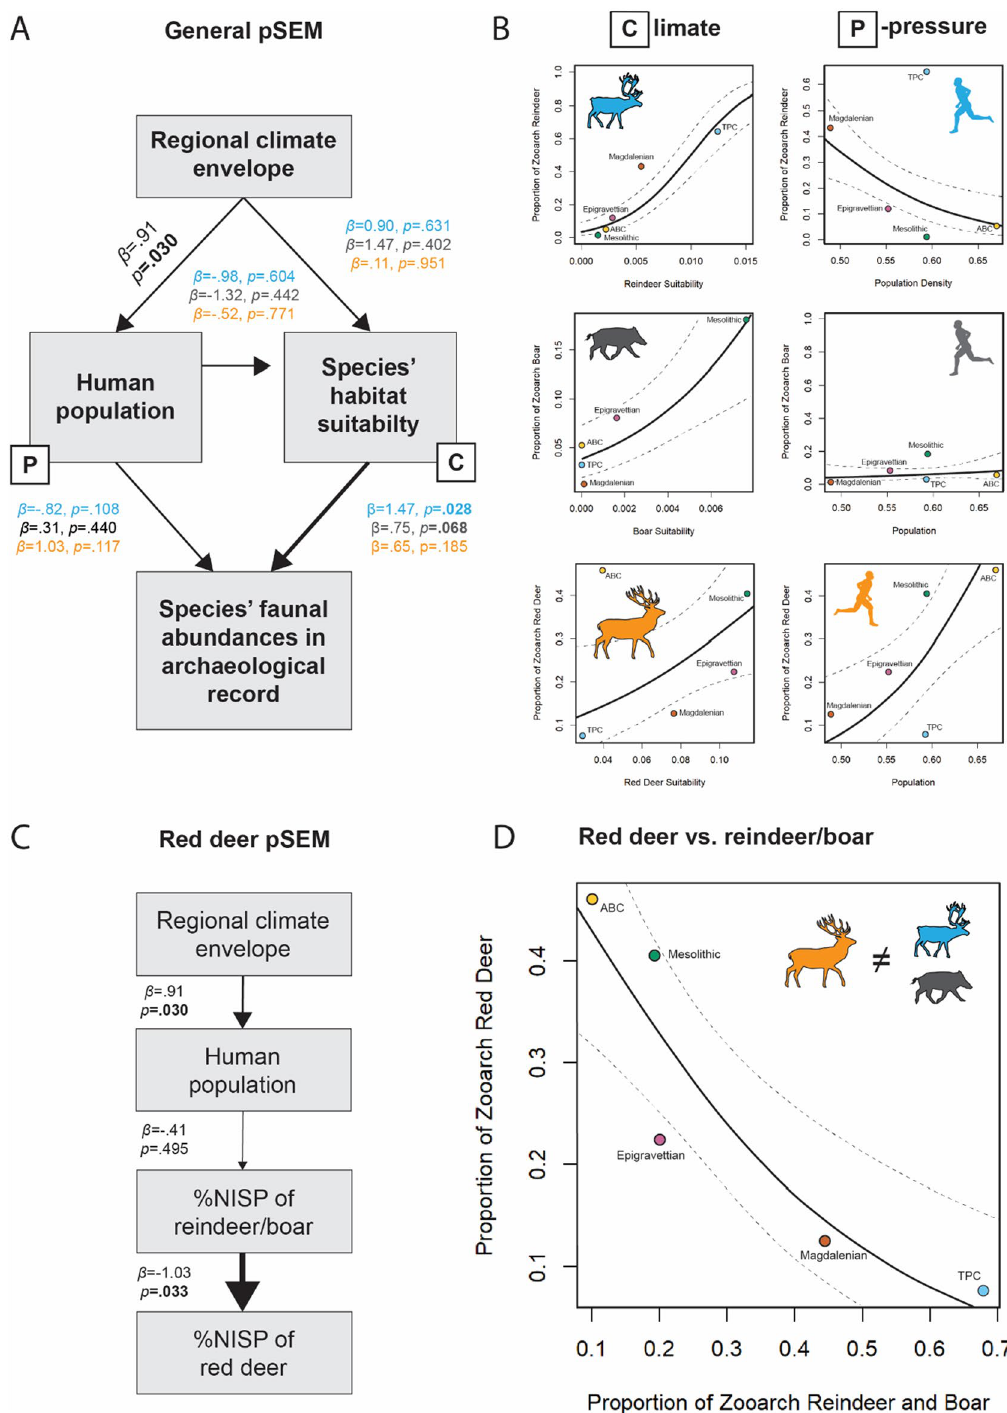
Figure 3. Relationship between climate and human population during the LUP based on the piecewise structural equation model (pSEM). ( A ) describes the structure of the pSEM used, wherein the zooarchaeological record is considered the product of the natural abundance of animal prey species in an occupied habitat and the effects of human population pressures on the available prey resources. The natural abundances of a species in an occupied habitat are then further influenced by human population densities and both are affected by regional climatic trends. ( B ) shows the model outputs for climate (C) and population (P) for each of the three considered top-ranked prey species (reindeer, boar, and red deer). ( C ) outlines the structure of the red deer-specific model, using an pSEM in which the abundance of red deer in the zooarchaeological record is structured by the abundance of reindeer and boar in the zooarchaeological record, which is regarded to be a product of human population density, in turn considered to be a product of regional climate. ( D ) shows the results of the red deer